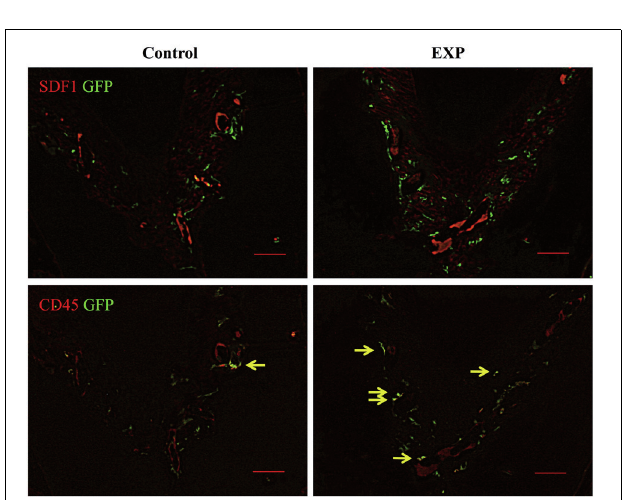
FIGURE 2 | Time-course observations of BMCs around periodontal tissue defects. Experimental periodontal tissue defects were introduced at the buccal surface of mandibular first molar roots in bone marrow chimeric mice. Five weeks after surgery, the number of GFP-positive cells was significantly elevated around the defects. Ten weeks after surgery, GFP-positive cells around the periodontal tissue defects decreased to control levels. G, gingiva; AB, alveolar bone; P, periodontal ligament; DP, dental pulp; D, dentin. (red). In experimental tissue the number of GFP( + )/CD45( + ) cells peaked at 13% GFP-positive cells.